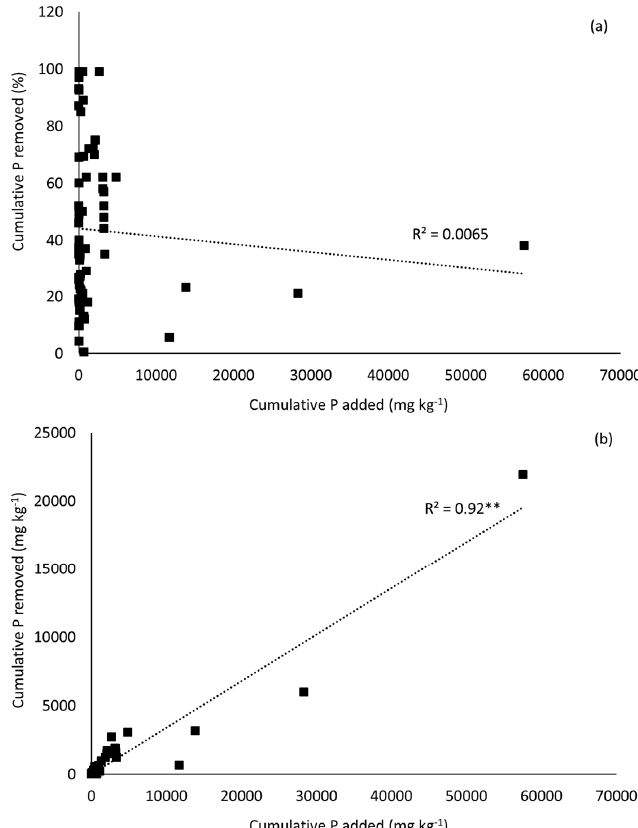
Figure 2. All cumulative P removal data from Table 1 expressed as: ( a ) a percentage; and ( b ) mg P removed kg − 1 P sorption material (PSM), plotted as a function of cumulative P loading.